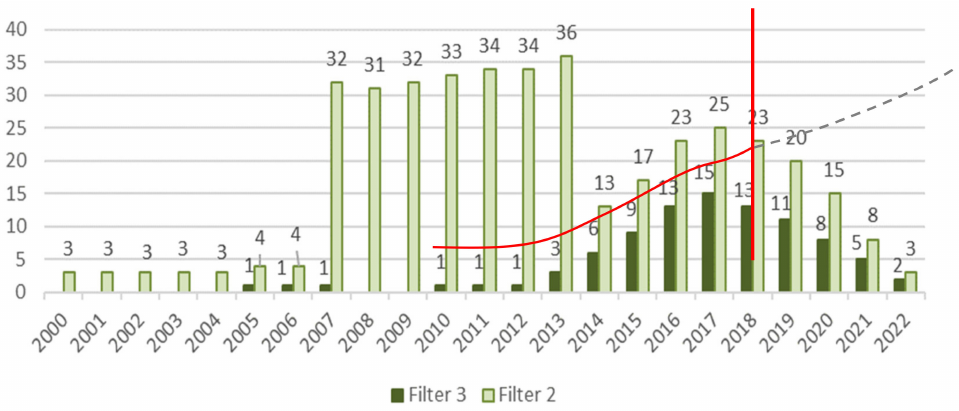
Figure 4. Number of projects per year applying filters 2 and